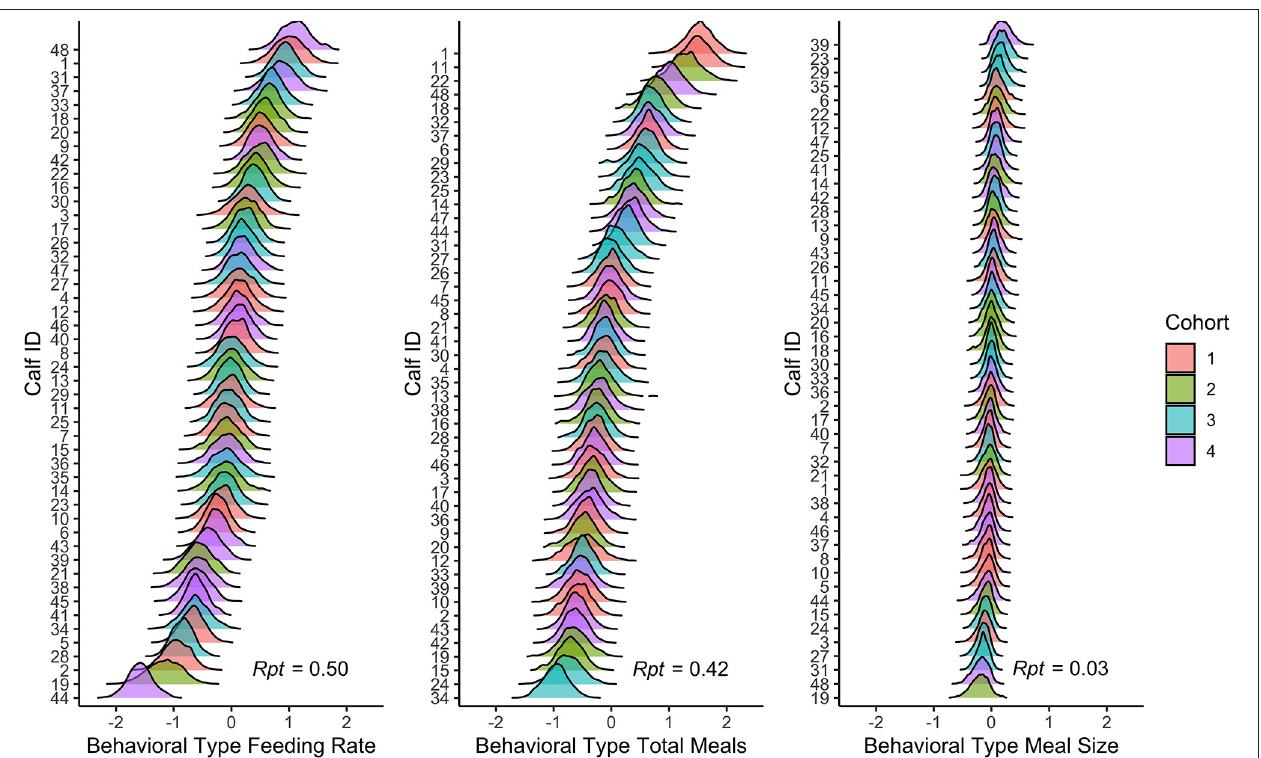
FIGURE 1 | Posterior distributions of behavioral types from the double hierarchical mixed models for feeding rate, total meals, and meal size for each calf. The models controlled for between-individual differences in age, day number, and cohort. Variables are Z-transformed (mean credible interval, and the different colors correspond to the different cohorts. Repeatability (Rpt) is reported in the bottom right corner of each